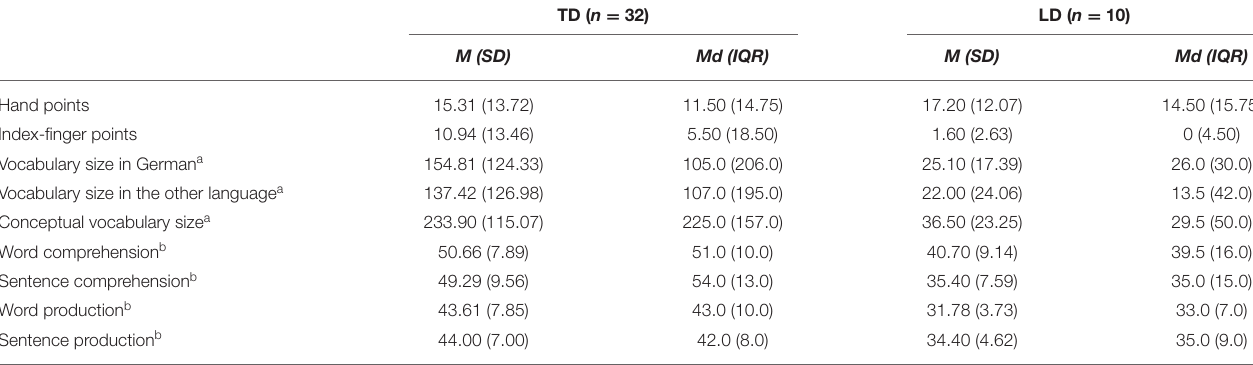
TABLE 1 | Descriptive statistics of gestural and linguistic skills in TD children and children with LD at 24 months.